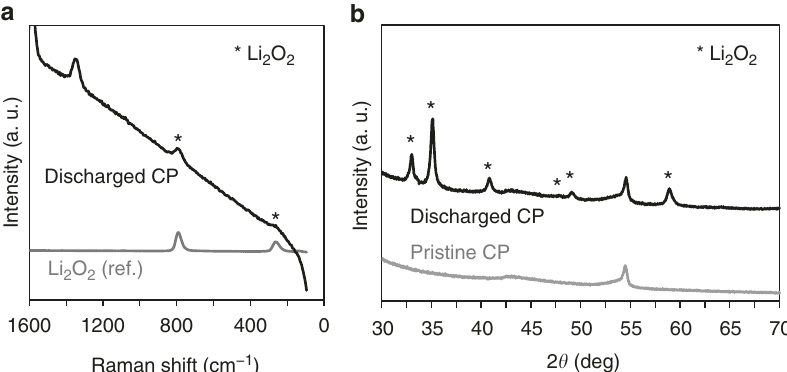
Fig. 2 Characterization of the discharged obtained from the MeCN system. a Raman spectra of the discharged CP and Li 2 O 2 reagent as a reference. b PXRD patterns of CP obtained before and after discharging